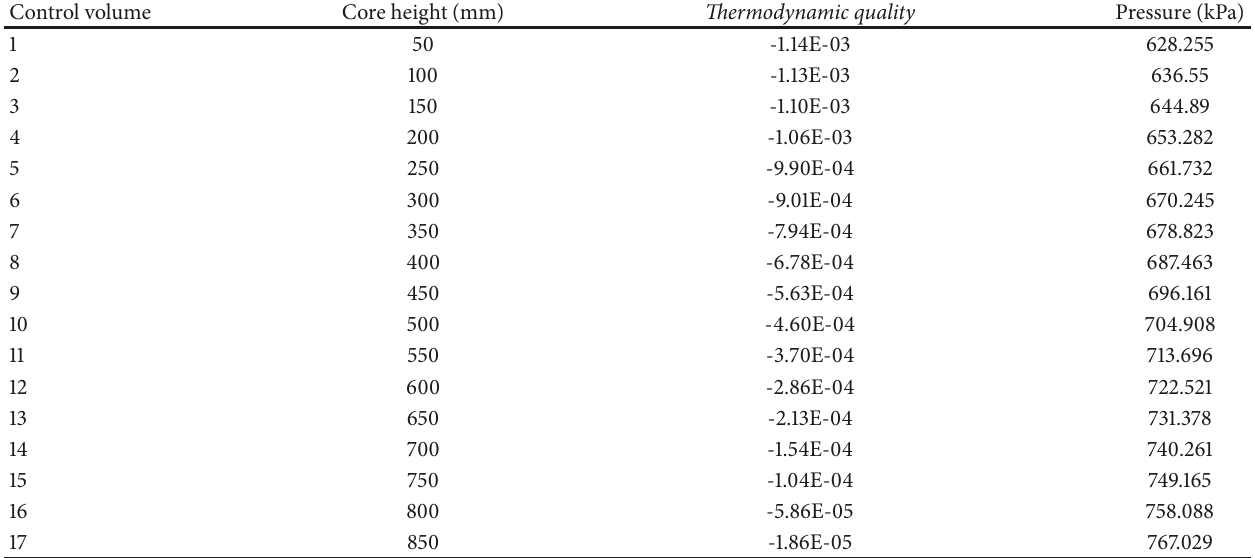
Table 4: Thermodynamic quality and pressure drop in the hot fuel assembly from the CARR reactor.